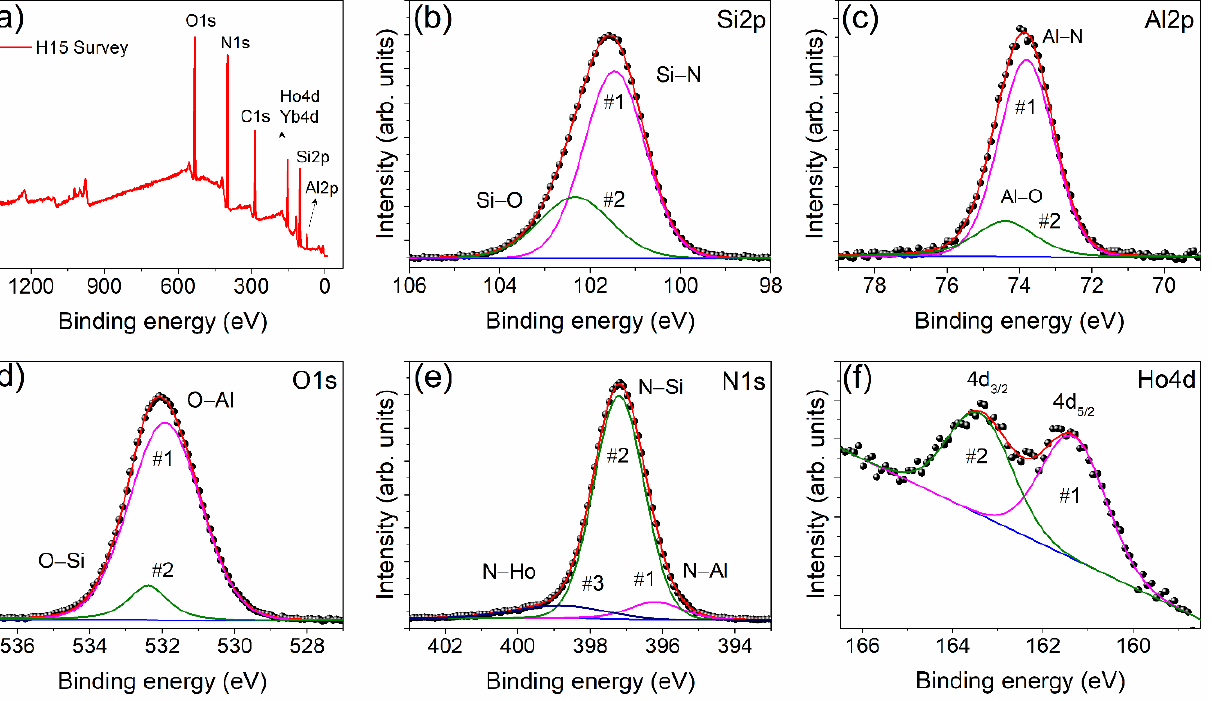
Figure 5. ( a ) XPS survey spectra of H15 sample. ( b – f ) are the high-resolution XPS spectra of constituent elements in the H15 sample. Dots represent the observed data points and continuous lines represent the fitted graph. Table 2. List of binding energy, full width at half maxima (FWHM), area, and proposed chemical- bond assignments. Integer identifiers are assigned with the lowest binding energy sub-peak as #1 to the sub-peaks within a given elemental peak. The unit of binding energy, FWHM, and the area are electron volts (eV).